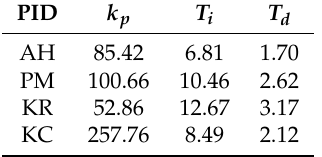
Table 2. PID parameters with different autotuners for the single input single output (SISO) system. PID